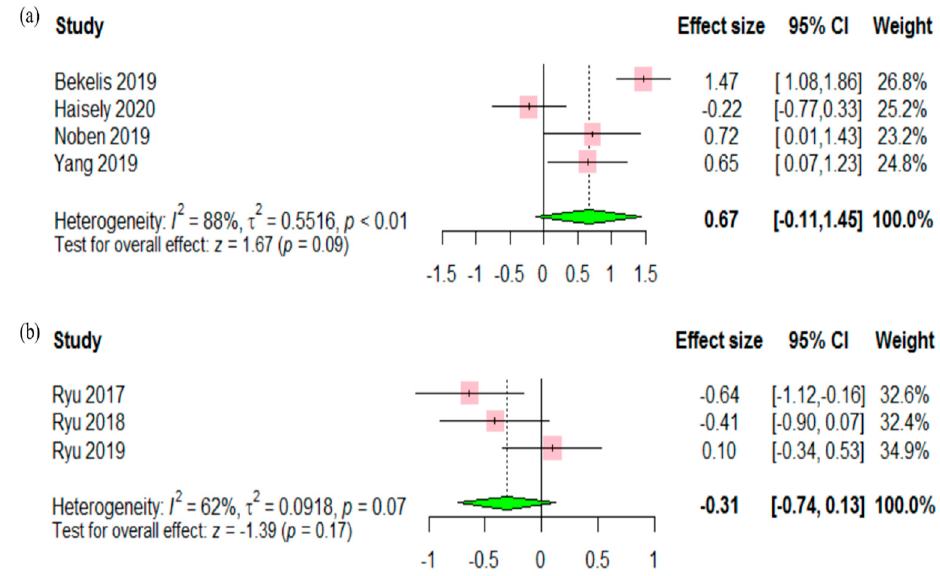
Figure 4. Forest plot comparing ( a ) satisfaction score and ( b ) behavior disturbance between the VR group and control group. Significant differences were not observed between the two groups.